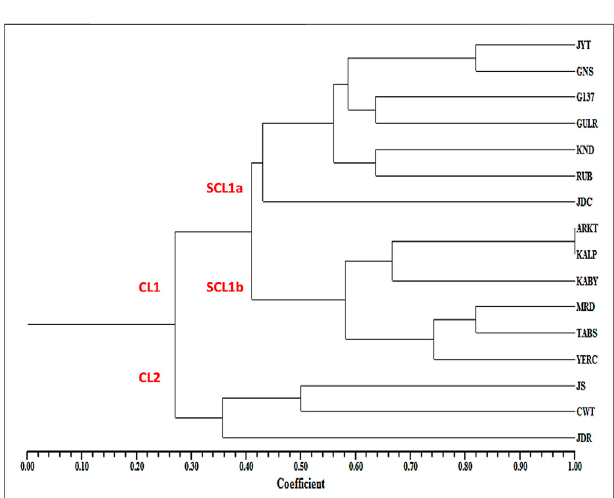
Frontiers in Genetics |